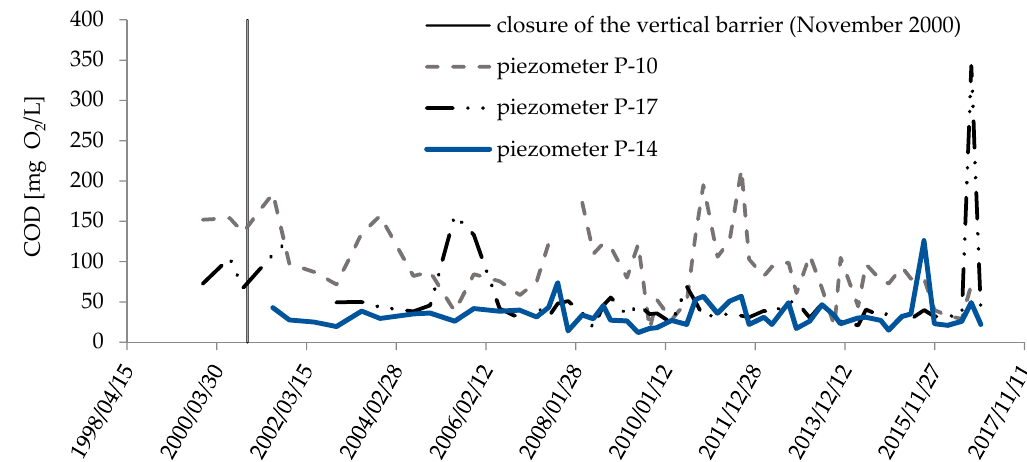
Figure 10. Temporal changes of the COD level in piezometers located in the area of adjacent facilities.